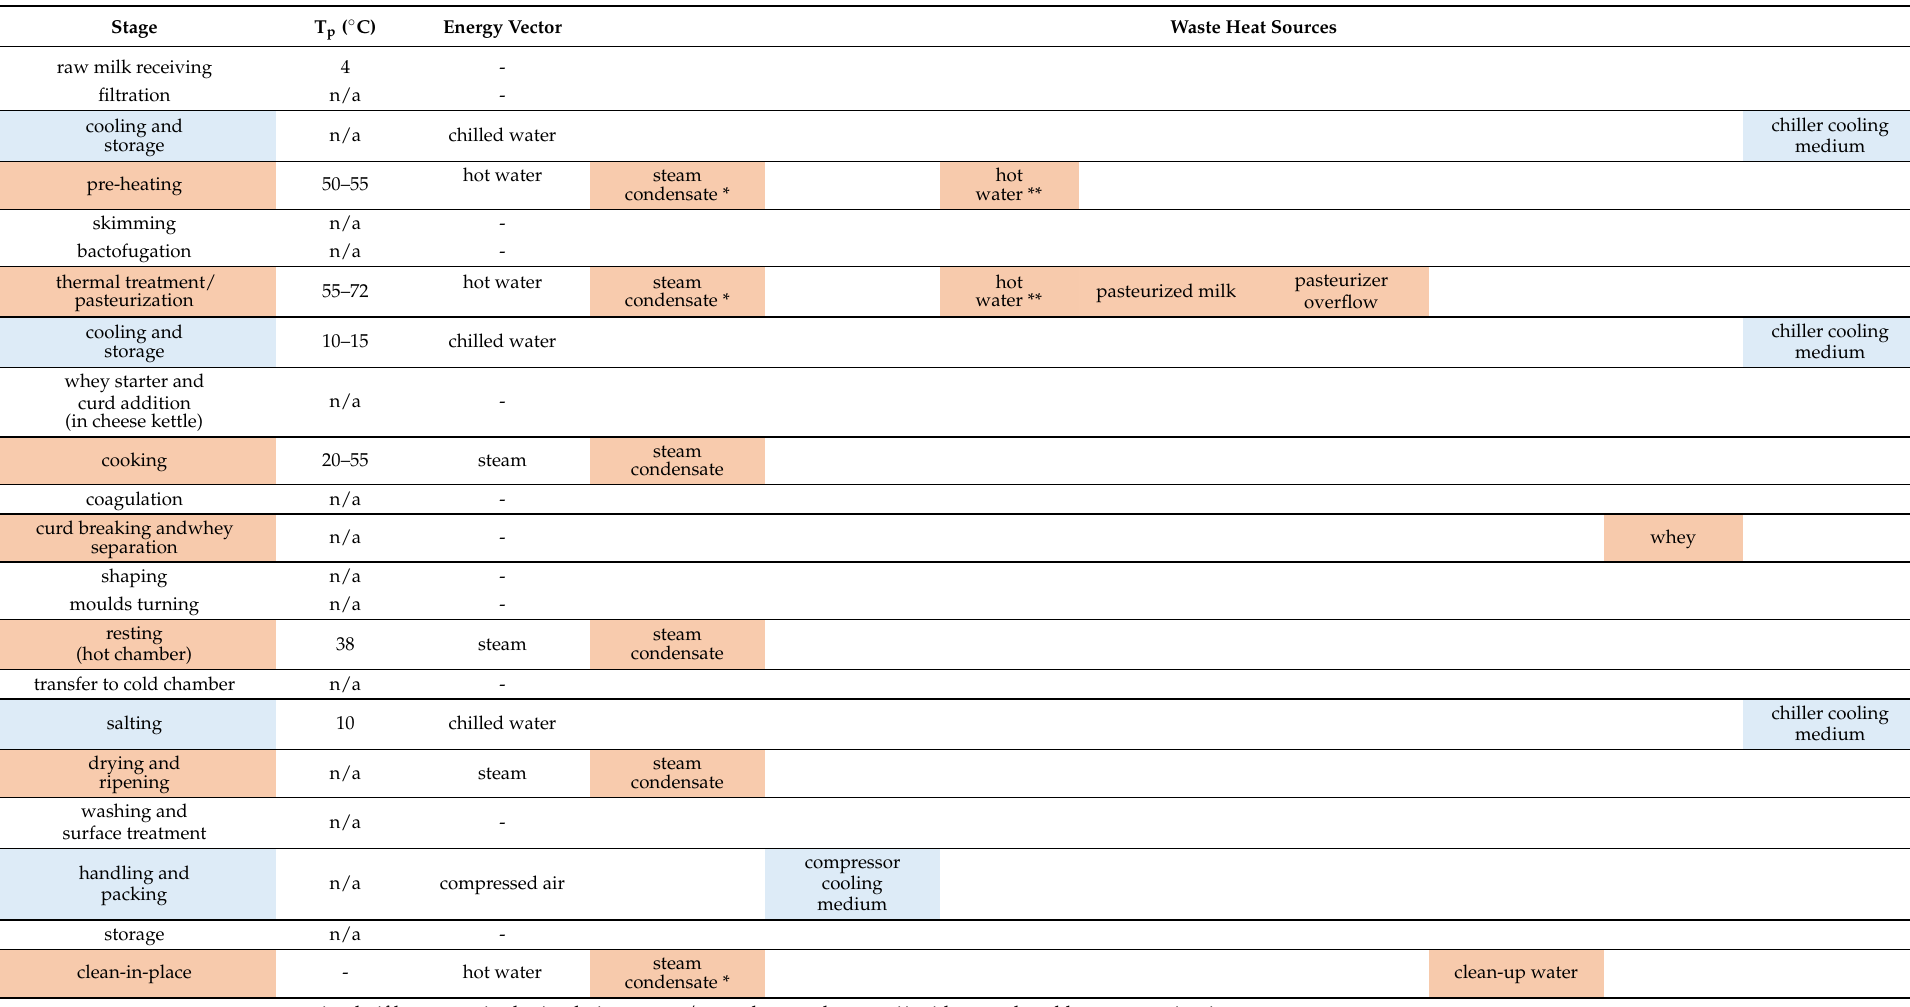
Table A7. Scheme of hard cheese manufacturing process and corresponding low-temperature waste heat